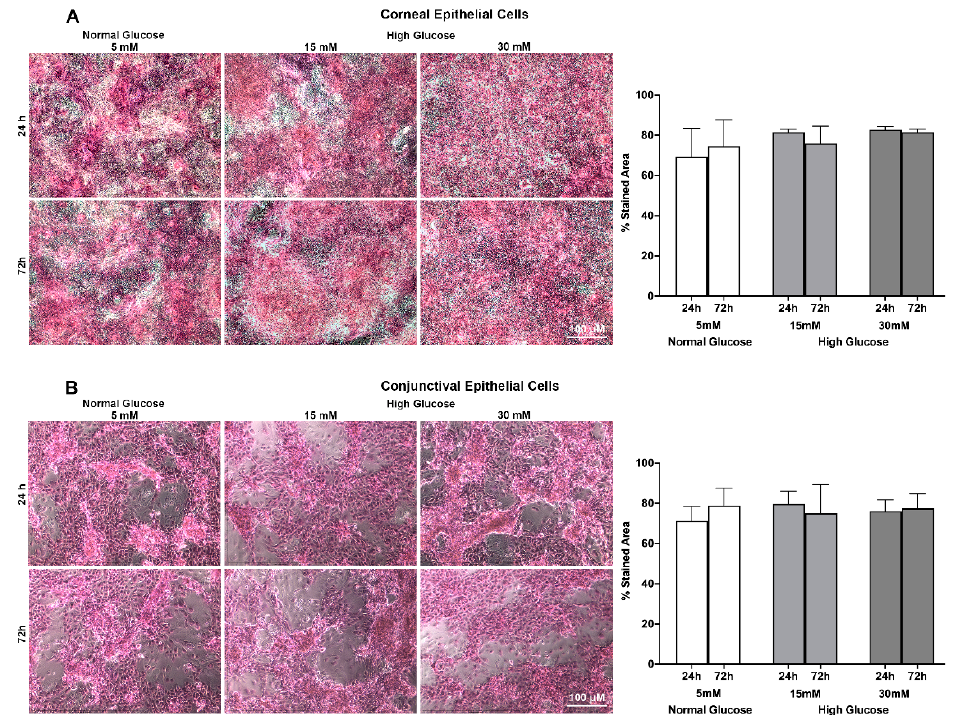
Figure 3. ( A ) Representative brightfield images showing effect of a high glucose level (15 mM; 30 mM) on MUC 16 barrier function as measured by rose bengal exclusion assay in stratified human corneal epithelial cells. ( B ) Representative brightfield images showing effect of a high glucose level (15 mM; 30 mM) on MUC 16 barrier function as measured by rose bengal exclusion assay in stratified human conjunctival epithelial cells. Epithelial cells with potential loss of MUC 16 are stained pink with rose bengal. Graphs show the percent-stained area as quantified using Image J software of n = 6 images/group. The images were obtained from cell culture experiments conducted in triplicate. Scale bar = 100 μ M.